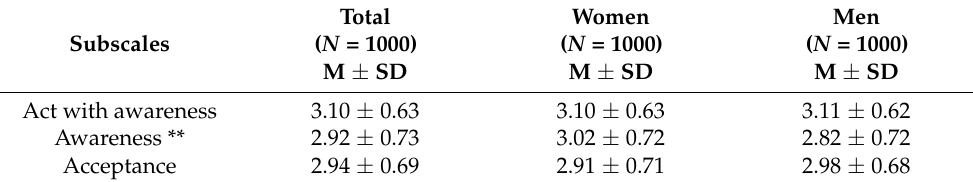
Table 9. Mean scores for MES